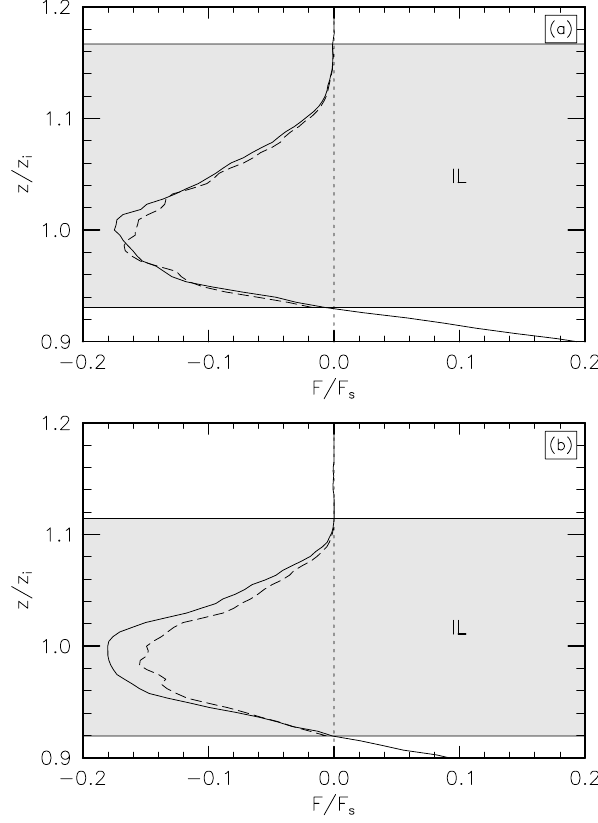
Fig. 6. Vertical profile of the heat fluxes e w 0 f 2 0 (–) and ϕ d (---) scaled by the surface heat flux F s at 12:00EST (a) and at 13:30EST (b) , as a function of the vertical coordinate z scaled by z i . The filled area represents the interfacial layer (IL).